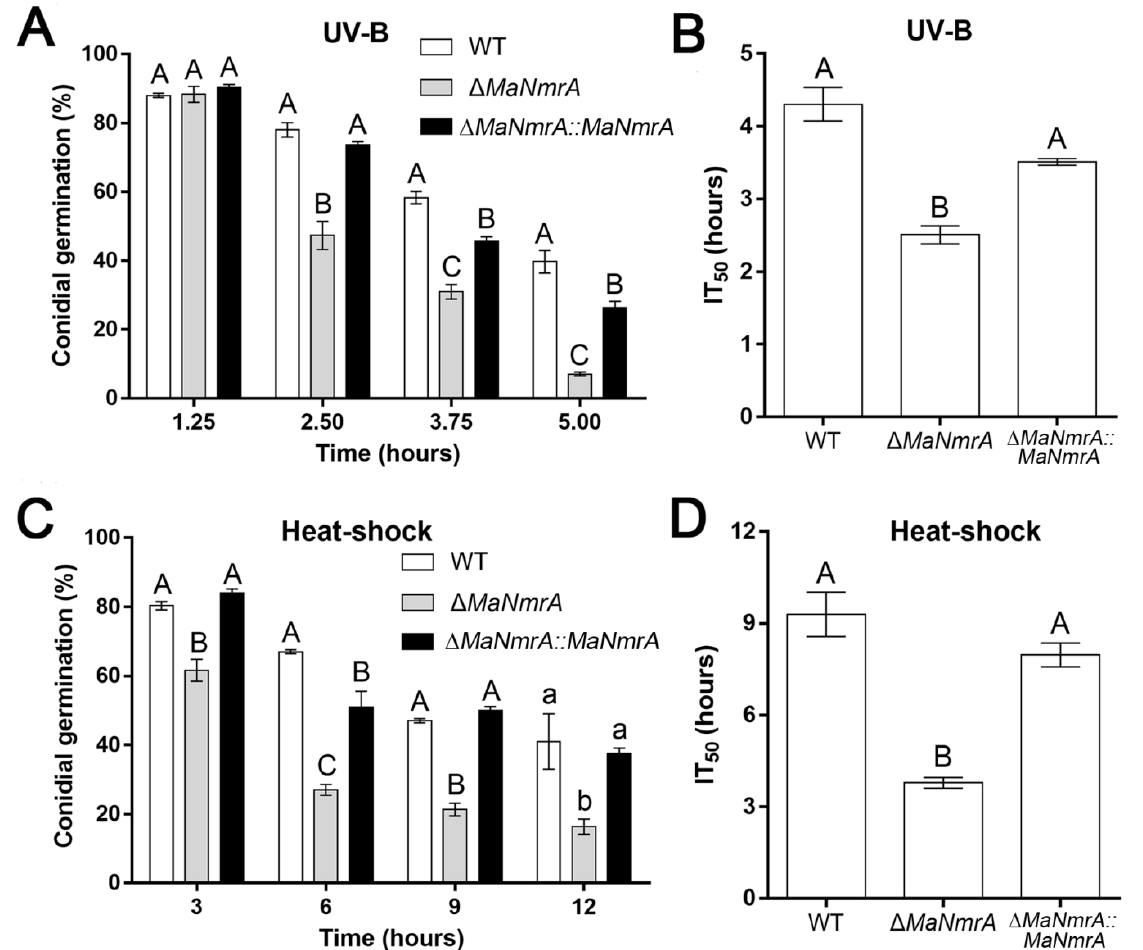
Figure 4. Disruption of MaNmrA reduced the tolerances to UV-B and heat-shock. Conidial germination ( A ) and the IT 50 s ( B ) of the WT, ∆ MaNmrA , and ∆ MaNmrA :: MaNmrA strains after treating with UV-B. Conidial germination ( C ) and the IT 50 s ( D ) of the fungal strains after treating with heat-shock. Letters A, B, a and b above graph were used to shown the significant difference. a and b, p < 0.05. A and B, p < 0.01 (Tukey’s HSD).